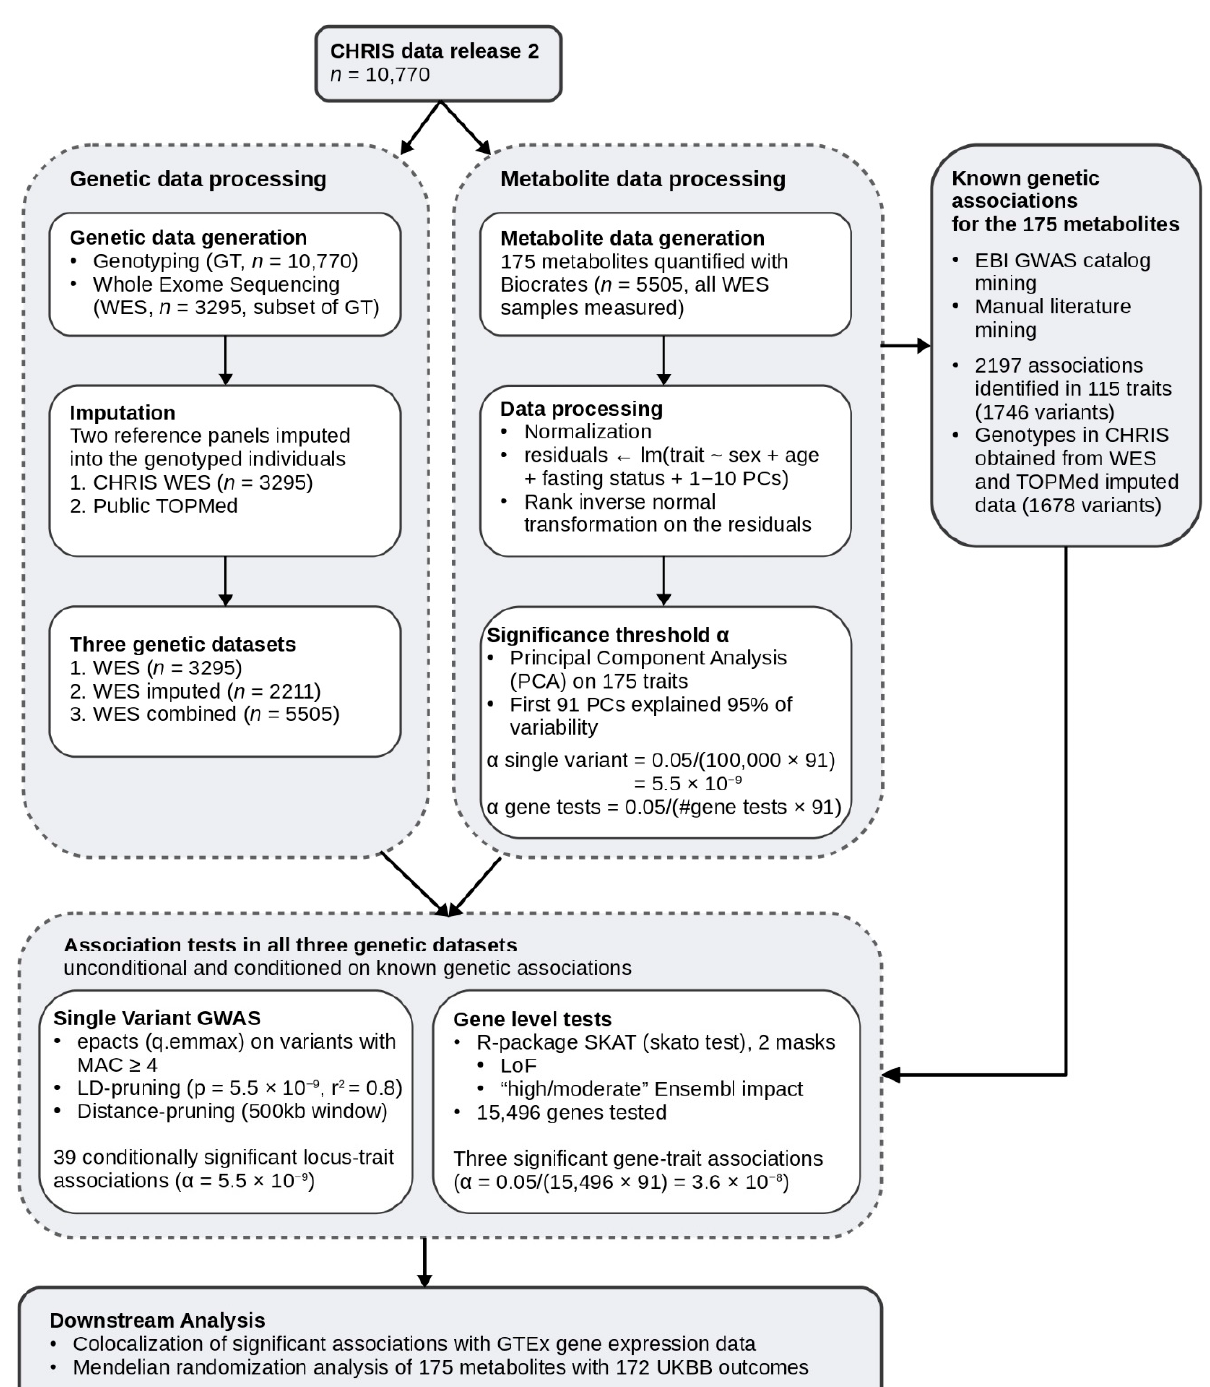
Figure 1. Flowchart of the study methods and summary of results.